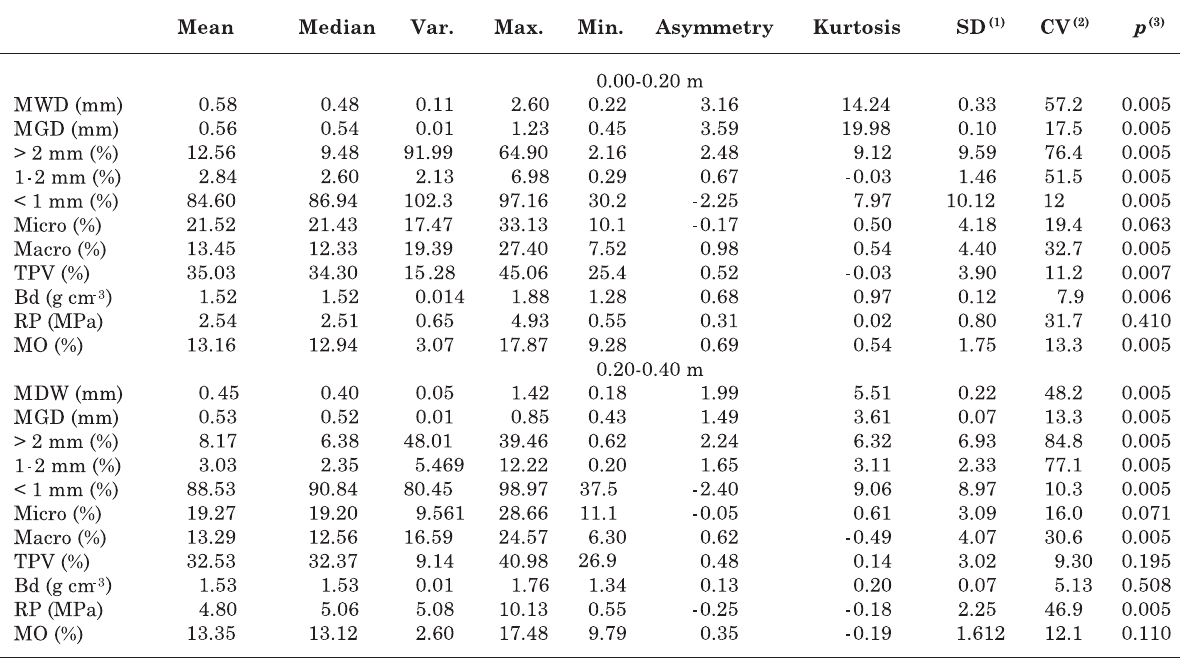
Table 3. Descriptive statistics of attributes in the concave area: mean weighted diameter (MWD), mean geometric diameter (MGD), aggregates > 2 mm (> 2 mm), aggregates 1–2 mm (1–2 mm) and aggregates < 1 mm (< 1 mm), micropores (micro), macropores (macro), total pore volume (TPV), bulk density (Bd), resistance to penetration (RP) and moisture (MO) in the 0–0.2 and 0.2–0.4 m